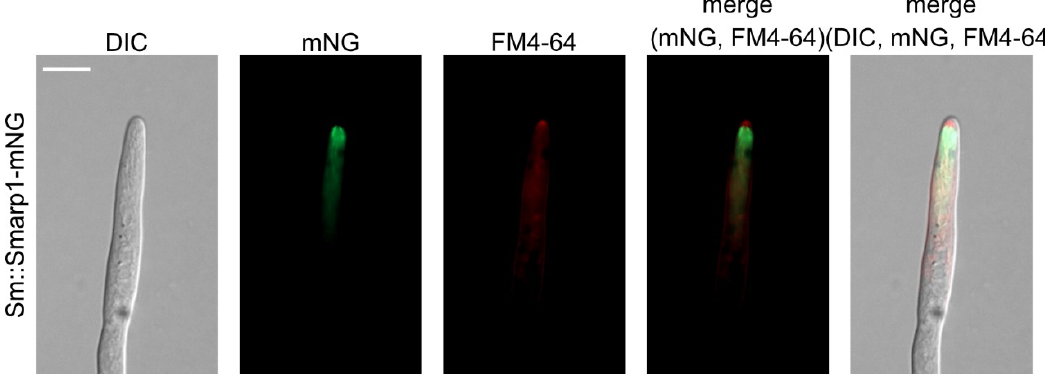
Figure 3. The localization of SmArp1-mNG together with FM4-64-stained hyphae in S. macrospora . The expression of pSmarp1-mNG in wild-type S. macrospora hyphae stained with FM4-64 (1 µg/mL in distilled water) and incubated for 15 min at 37 °C. The recording of hyphae was performed after growing on solid agarose-BMM for 24 h at 27 °C under continuous light conditions; scale bar = 10 µm.